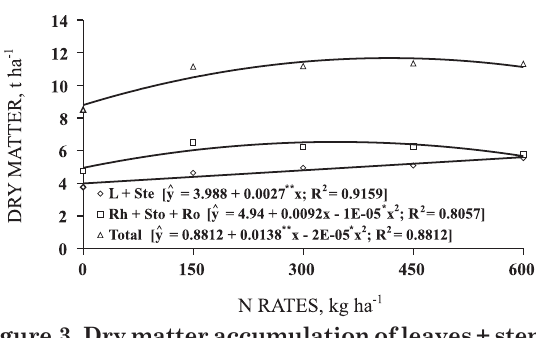
Figure 3. Dry matter accumulation of leaves + stems (L + Ste), rhizomes + stolons+ roots (Rh + Sto+ Ro) and total of Bermuda grass, in relation to N rates.